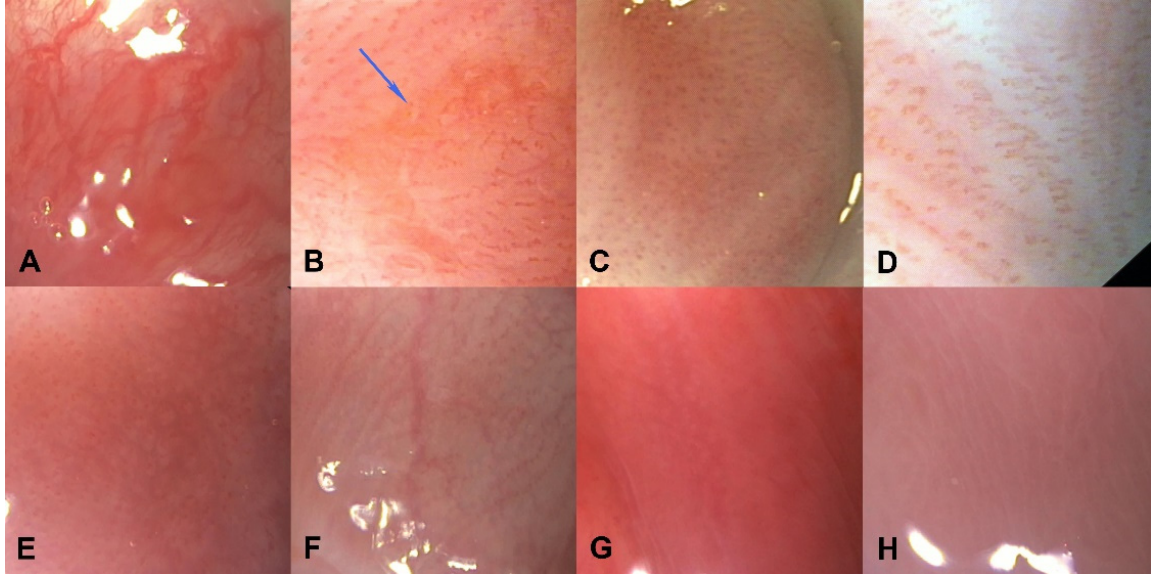
Figure 2. Normal squamous mucosa and minimal changes characteristic of GERD in magnifying endoscopy. ( A )—normal squamous mucosa: palisade vessels clearly visible, no enlarged intrapapillary capillary loops (IPCLs); ( B )—microerosion pointed by blue arrow, enlarged IPCLs in the background; ( C )—enlarged IPCLs, palisade vessels obscured; ( D )—elongated IPCLs; ( E )—white spots encircling enlarged IPCLs; ( F )—enlarged IPCLs (right side of picture) and white spots visible regardless of IPCLs (left side of the picture); ( G )—white spots; ( H )—palisade vessels obscured.